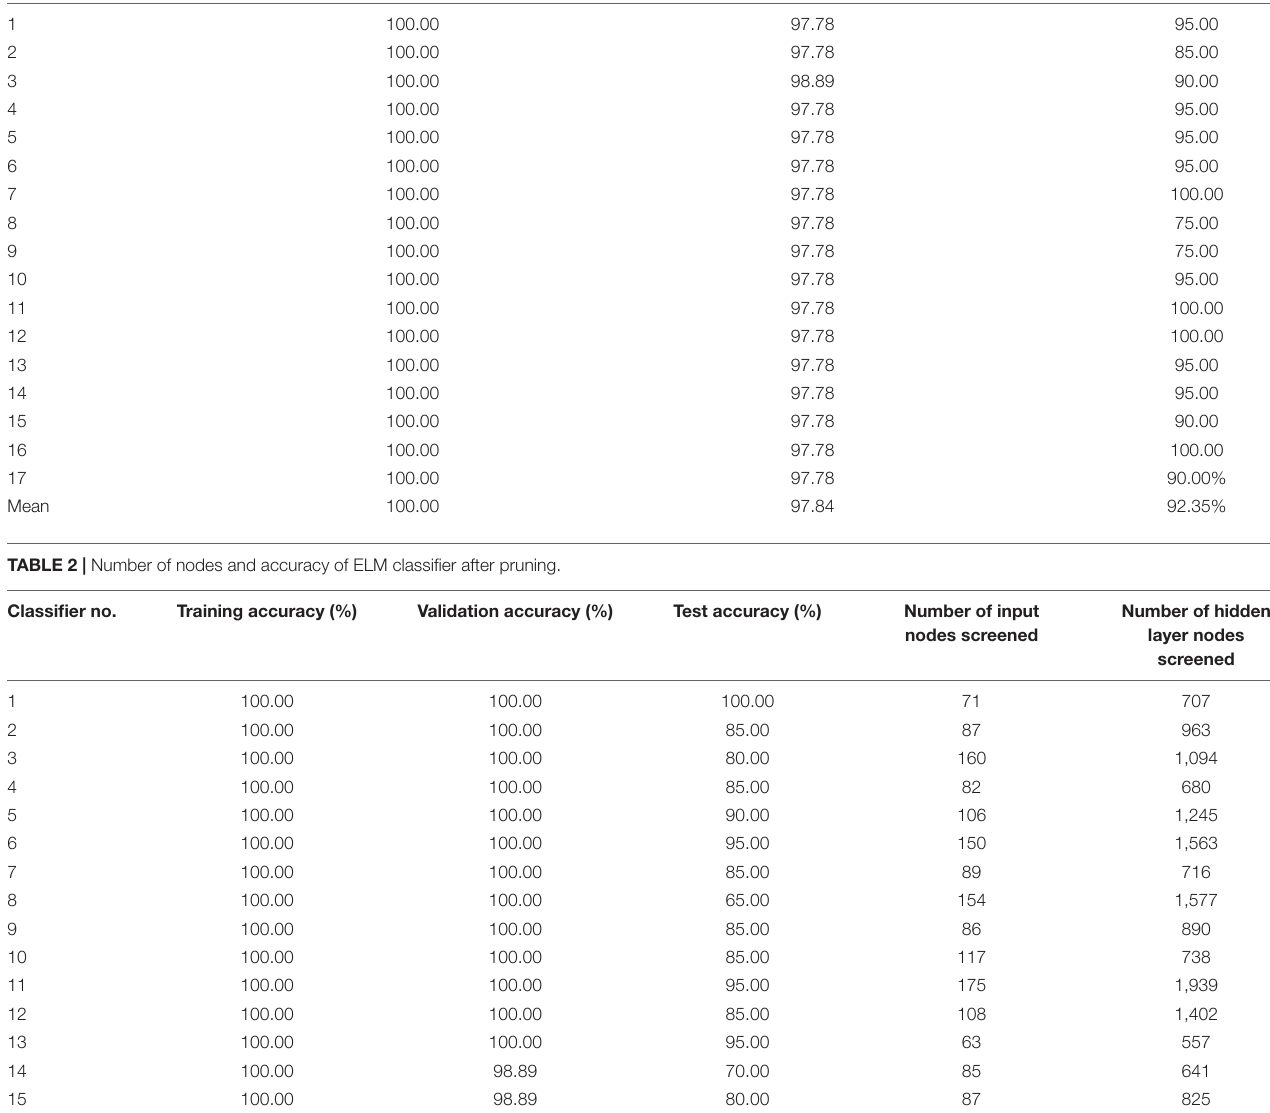
TABLE 1 | Accuracy of ELM trained with full amount of features, Classifier no.